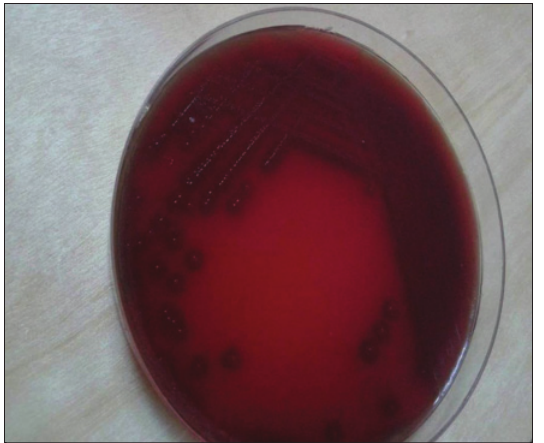
Figure-2: Streptococcus equi on blood agar media showing beta-hemolytic dew-drop like colonies.